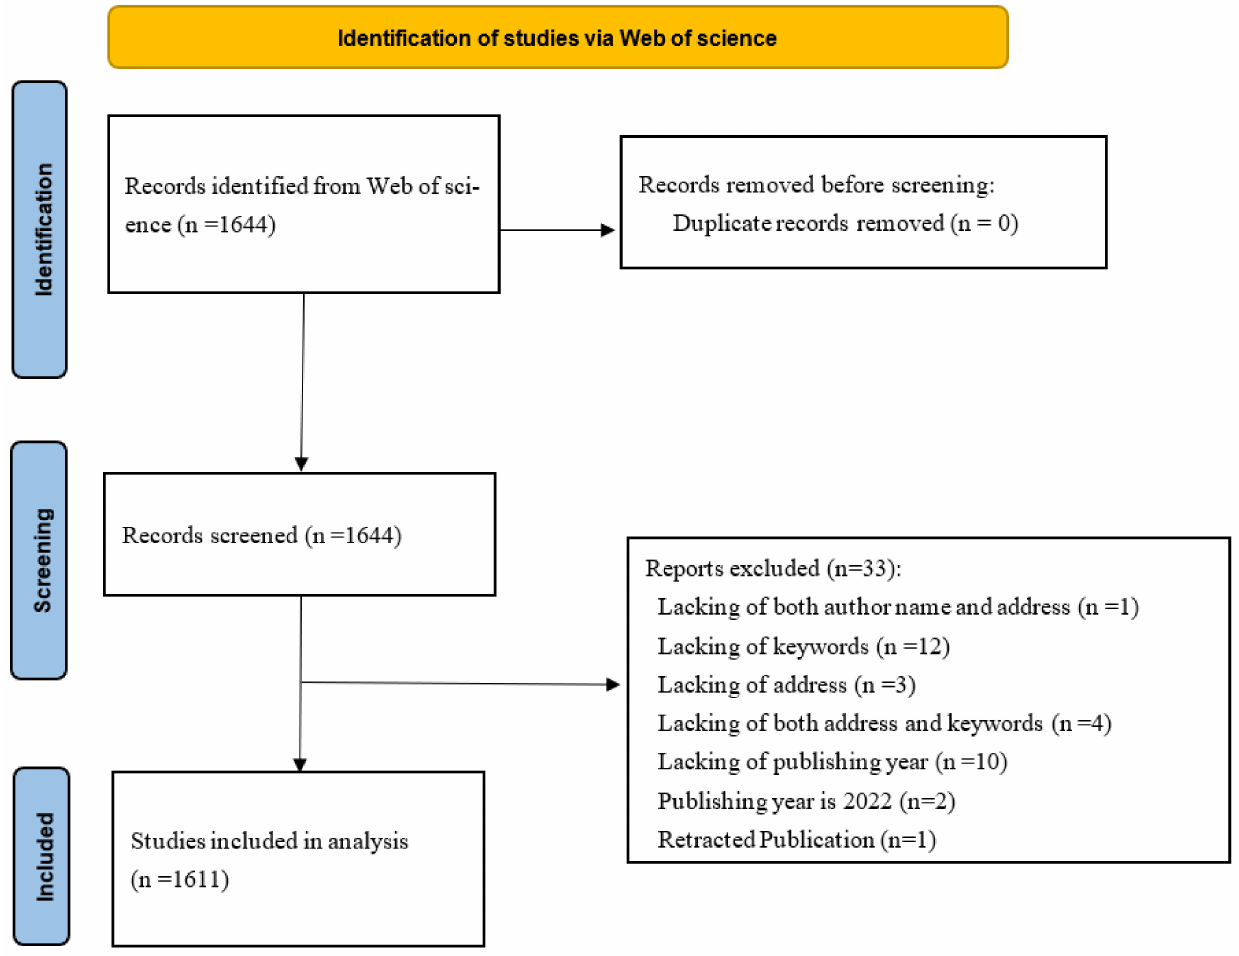
Figure 1. The flow chart of searching and selecting